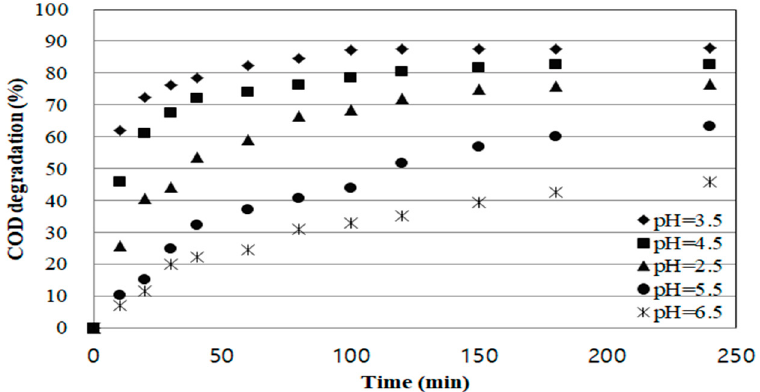
Figure 3. The influence of pH on the degradation of COD (Fe 2 + = 0.01 M, H 2 O 2 = 0.1 M, reaction time = 240 min, UV 254 intensity = 3.524 mW / cm 2 ).